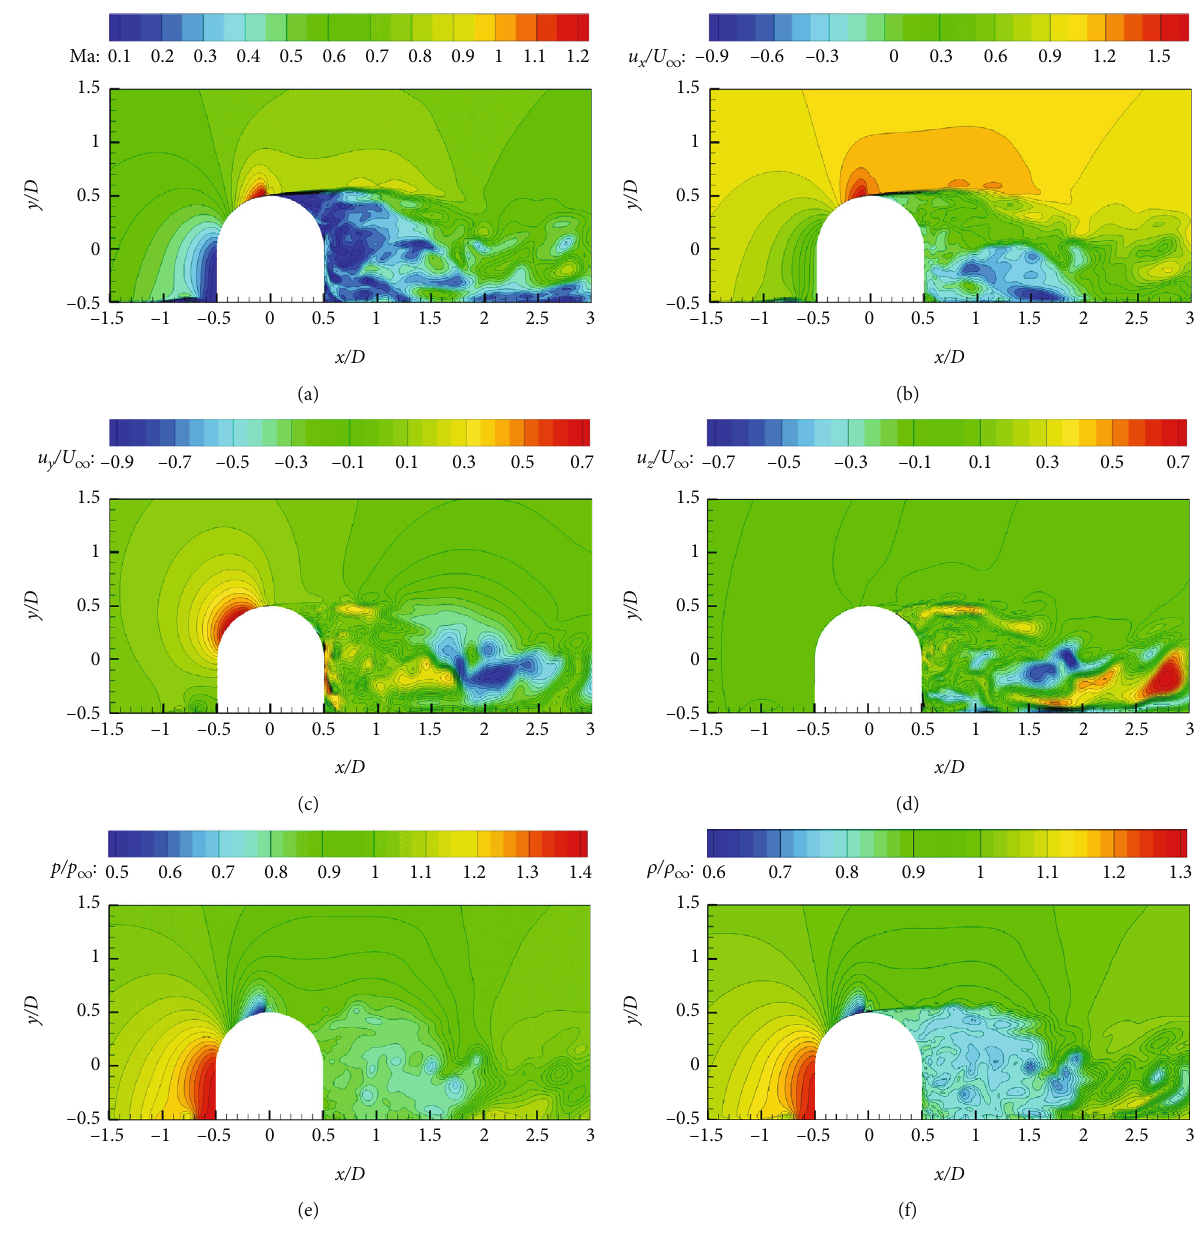
Figure 7: Transient fl ow snapshot along the turret centerline ( z = 0 ): (a) Mach number, (b) streamwise velocity, (c) vertical velocity, (d) spanwise velocity, (e) static pressure, and (f)